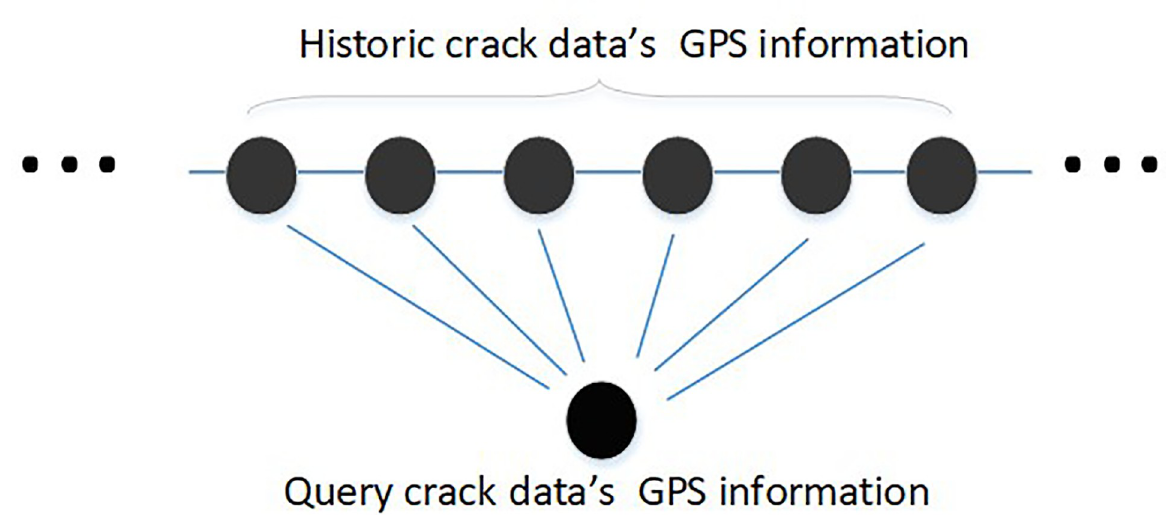
Fig 2. Coarse localization from GPS coordinate